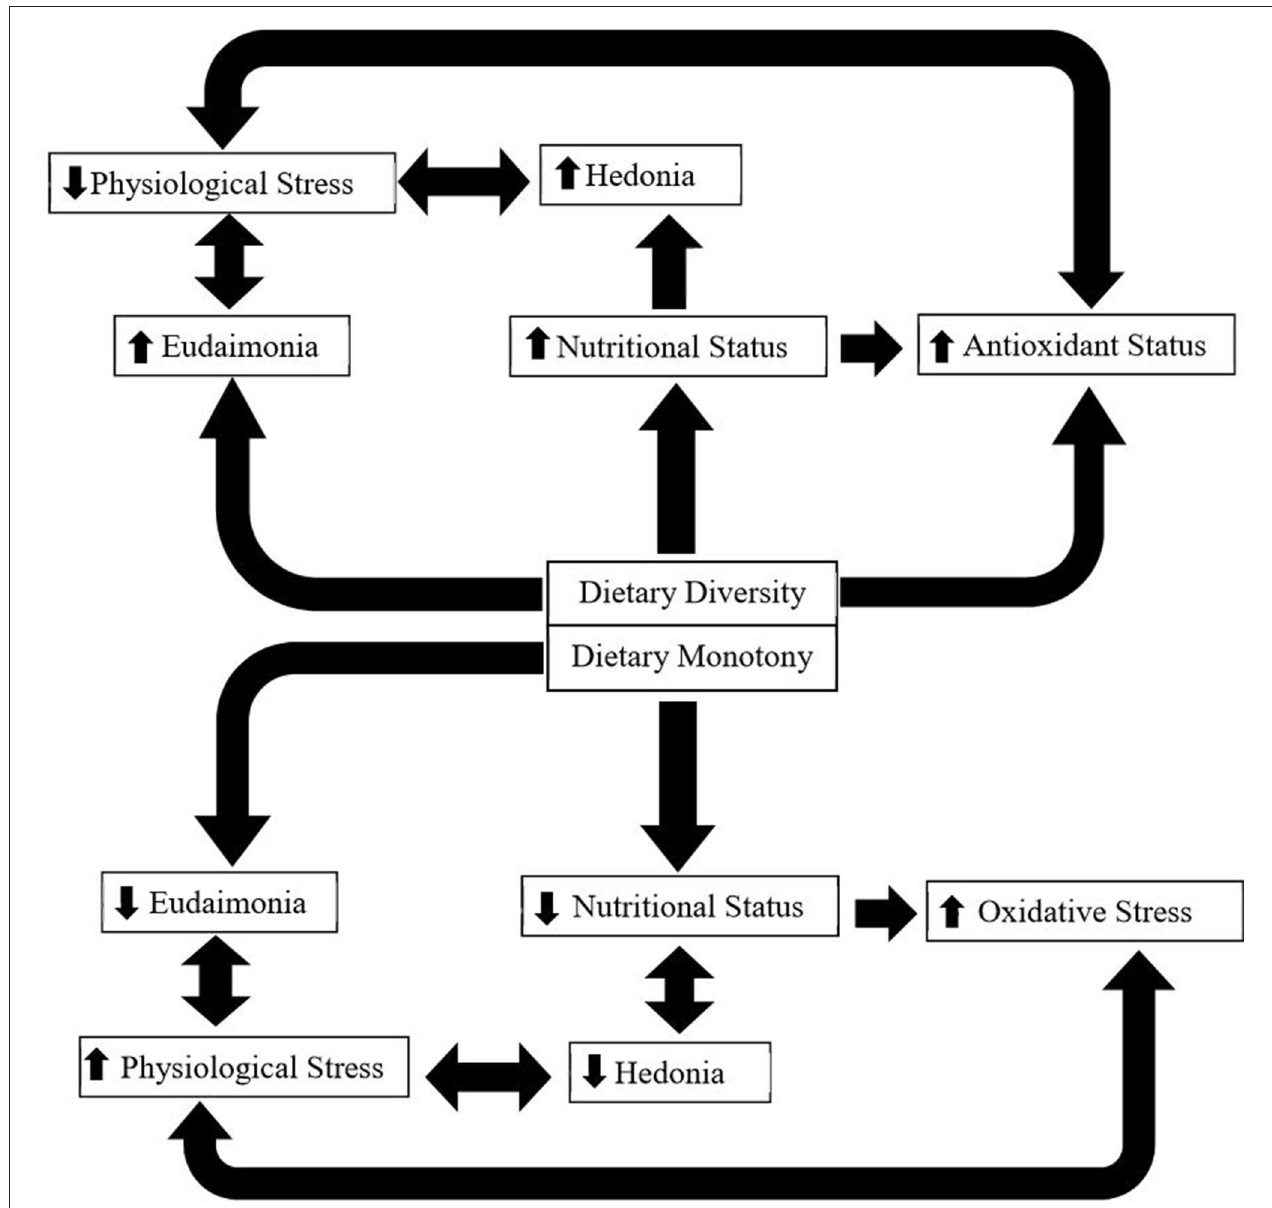
FIGURE 1 | This figure shows a conceptual model depicting how dietary diversity vs. monotony may affect ruminants. Dietary diversity improves nutritional status, through ingesting complimentary plant compounds (primary and secondary); improves hedonic and eudaimonic well-being; decreases physiological stress; and improves antioxidant status, through the ingestion of plant secondary compounds that exhibit antioxidant effects. It is important to note that both nutritional status and physiological stress can also impact antioxidant status directly. On the other hand, dietary monotony may reduce nutritional status (by not allowing animals to mix a diet containing a balance of plant primary compounds) and hedonic (reduced nutritional status) and eudaimonic (loss of choice)